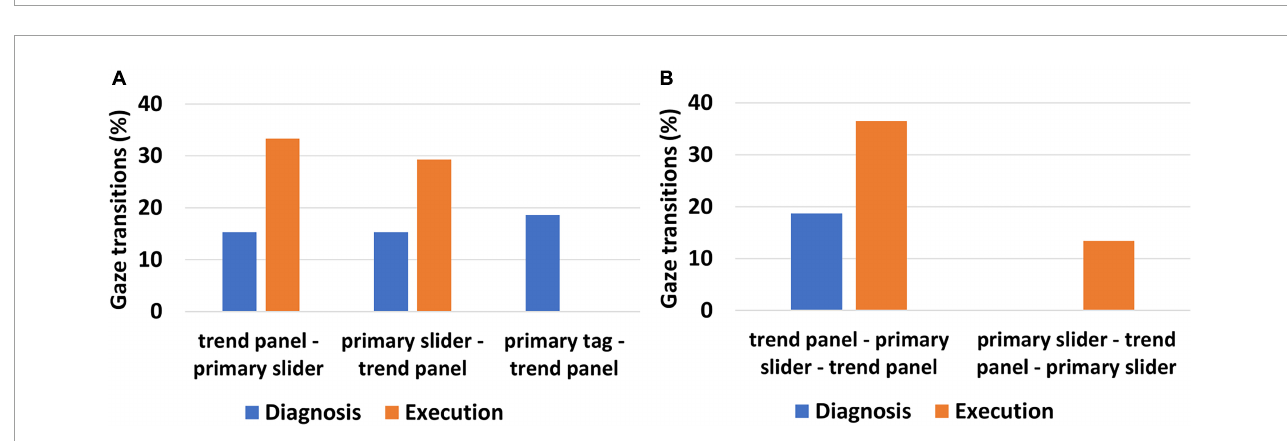
FIGURE6 Gaze transition analysis of the human digital twin during diagnosis and execution phase (A) two tuple gaze transition for the HDT during failure trials (B) three tuple gaze transition for the HDT during failure